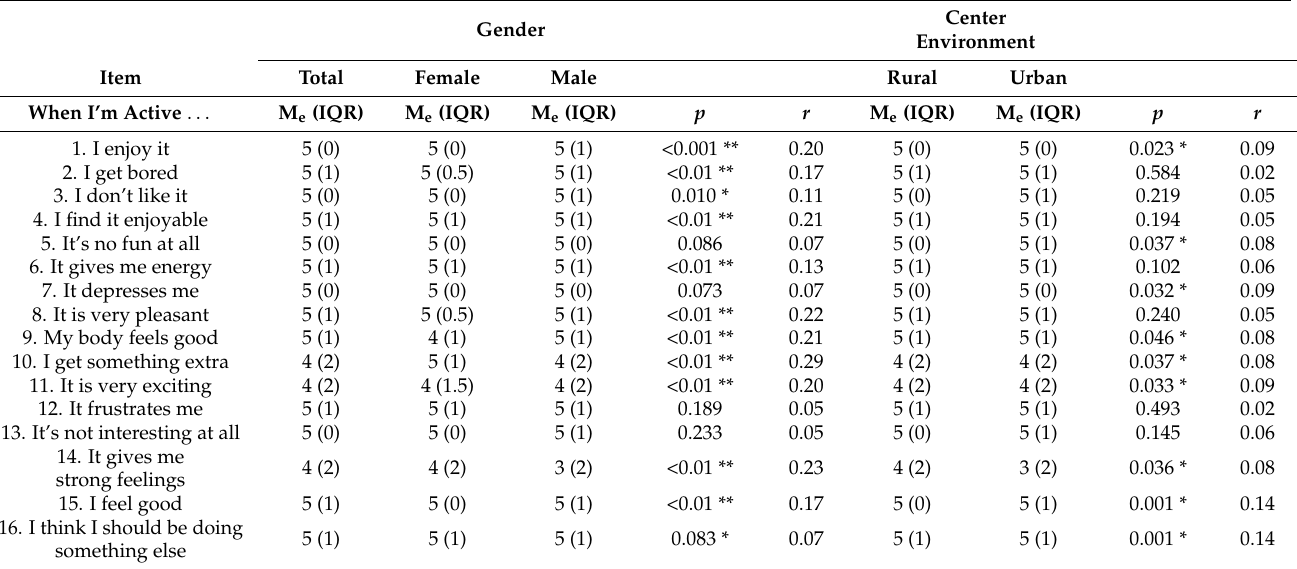
Table 2. Descriptive analysis and differences by sex and center location of the questionnaire items. Gender